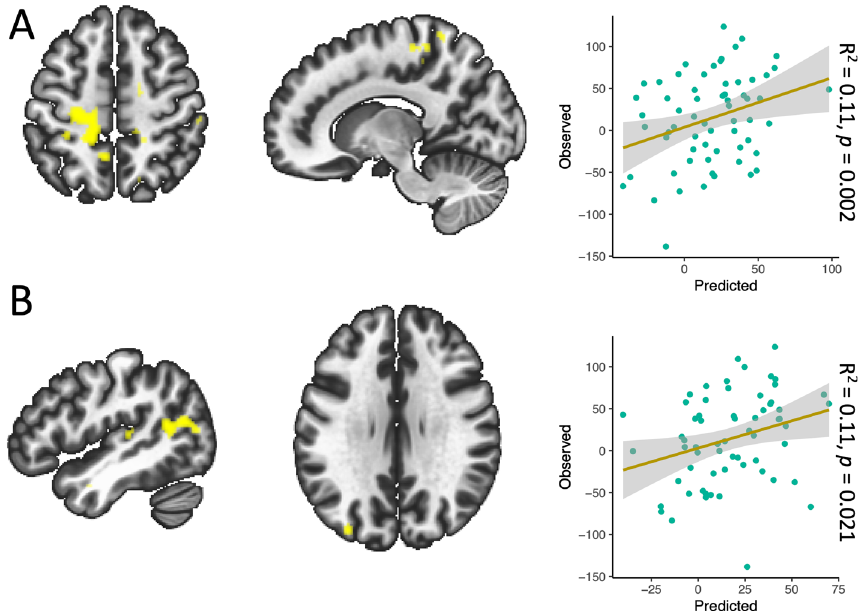
Figure 3. Summary figure of cluster regions predictive of change in time spent sedentary for each seed ( A = aMCC, B = r-dA) and scatter plots of predicted vs observed values. Each summary figure represents the mean mask from each outer layer leave-one-out cross validation iteration that predicted the left-out subject’s change in time spent sedentary in the inner layer. For the aMCC seed ( A ), the mean cluster spanned regions in the primary motor cortex (axial slice view) and the supplementary motor area (sagittal slice view). For the r-dAI seed ( B ), the mean cluster mask spanned the middle temporal gyrus, angular gyrus and lateral occipital